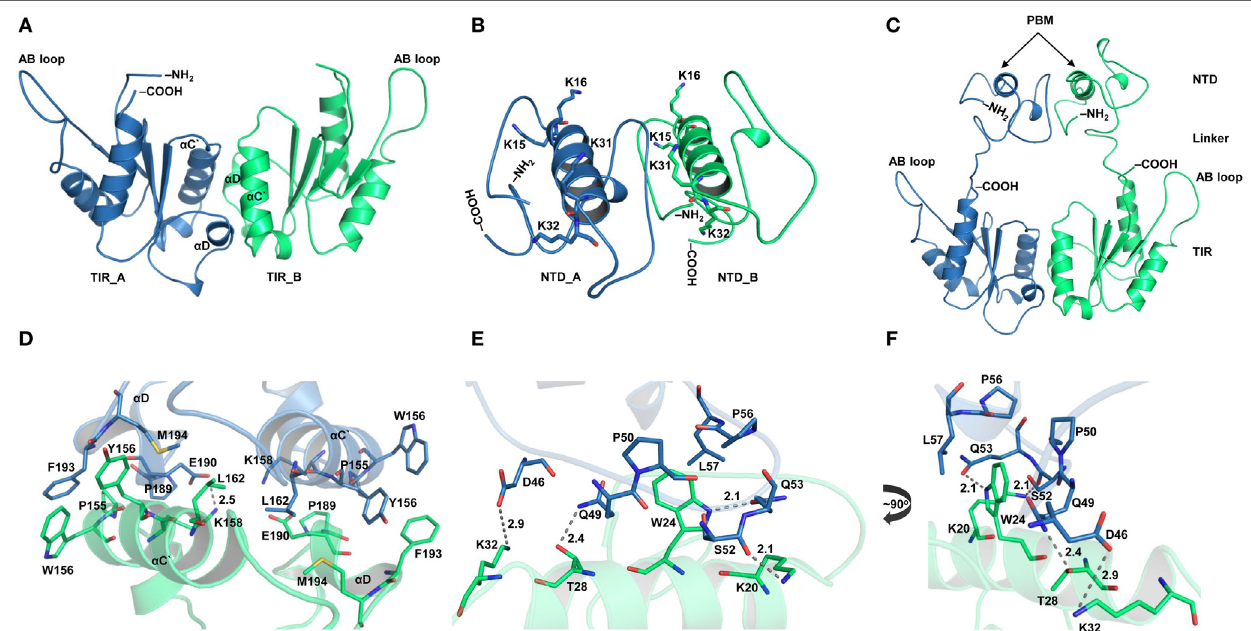
FigUre 2 | Structural organization of individual domains of toll/interleukin 1 receptor (TIR) domain-containing adaptor protein (TIRAP). (a) The overall structure of a modeled TIR domain dimer. (B) A predicted model of the N-terminal domain (NTD). (c) Initial model (energy minimized) of a full-length TIRAP with the NTD and TIR domains arranged in a physiological dimeric condition. (D) A closer view of the dimer interface between TIR monomers involving residues from α C ′ and α D helices. (e) A detailed view of the NTD dimerization, including residues from both phosphatidylinositol (PI)-binding motif (PBM) and PI-binding domain (PBD). (F) A 90° rotated view of panel (e) for clarity. Dashed lines represent hydrogen bonds, and digits indicate distances in angstrom